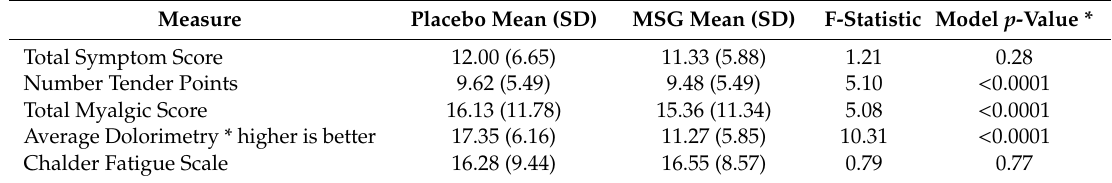
Table 5. Results of the crossover challenge with MSG relative to